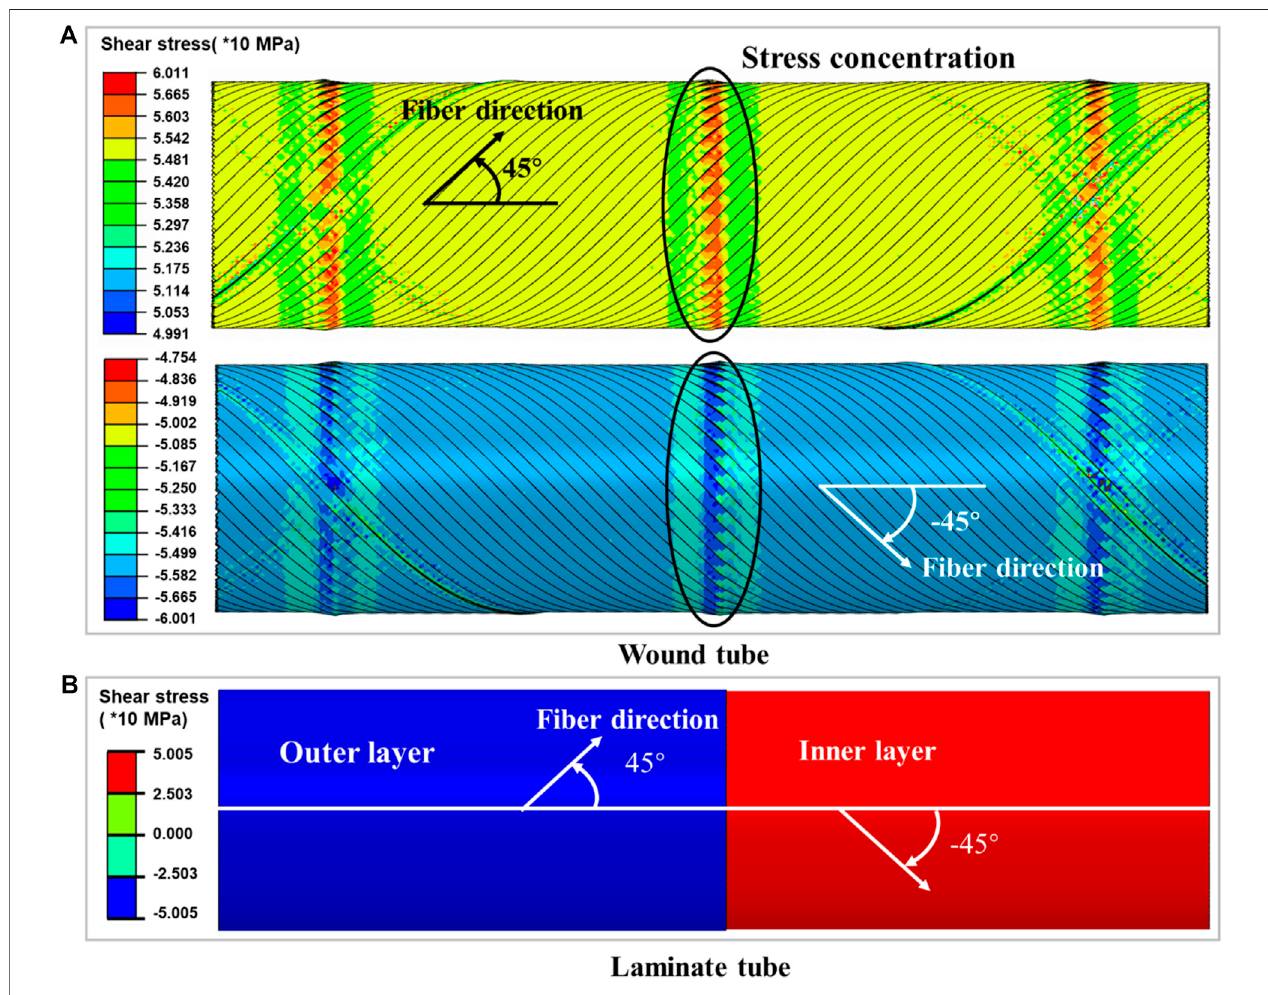
FIGURE 10 | The shear stresses of tubes. (A) wound tube; (B) laminated